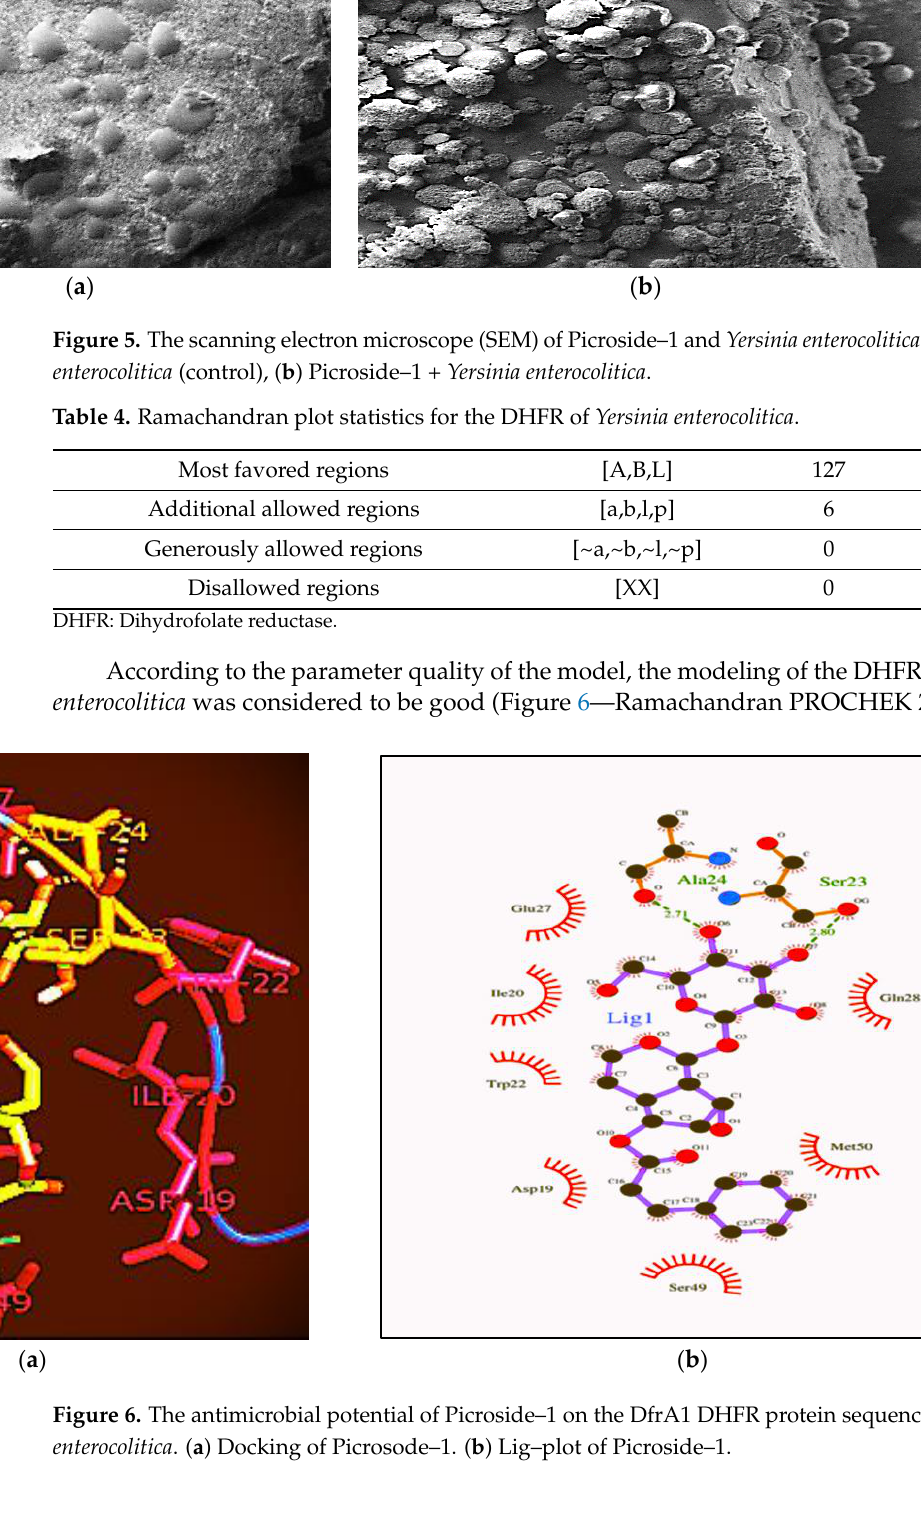
Table 5. Total estimated energy and the hydrophilic and hydrophobic interaction between the protein and ligand. Compound